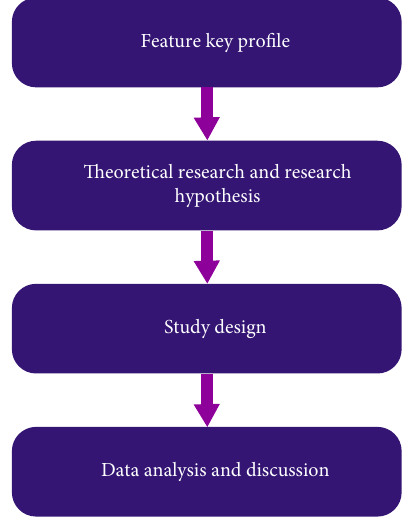
Figure 1: Flow chart of this